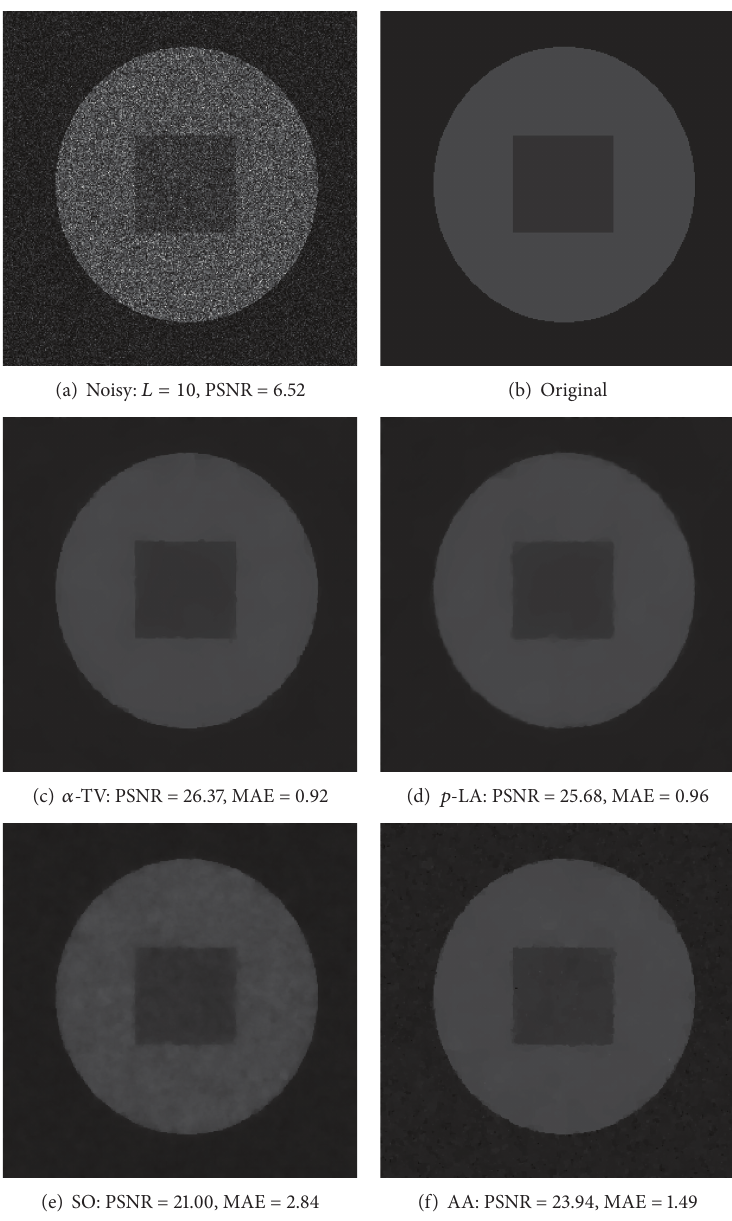
Figure 4: Synthetic image ( 300 × 300 ) (a) Noisy image corrupted by speckle noise for 𝐿 = 10 in (8). (b) Original image. (c) Our algorithm by 𝛼 -TV, 𝜎 = 2 , 𝑘 = 0.05 , 𝜏 = 0.05 . (d) Our algorithm by 𝑝 -LA, 𝑝 𝑈 = 1.2 . (e) SO algorithm, 𝜆 = 0.7 , 𝛼 = 0.25 . (f) AA algorithm, 𝜆 = 240